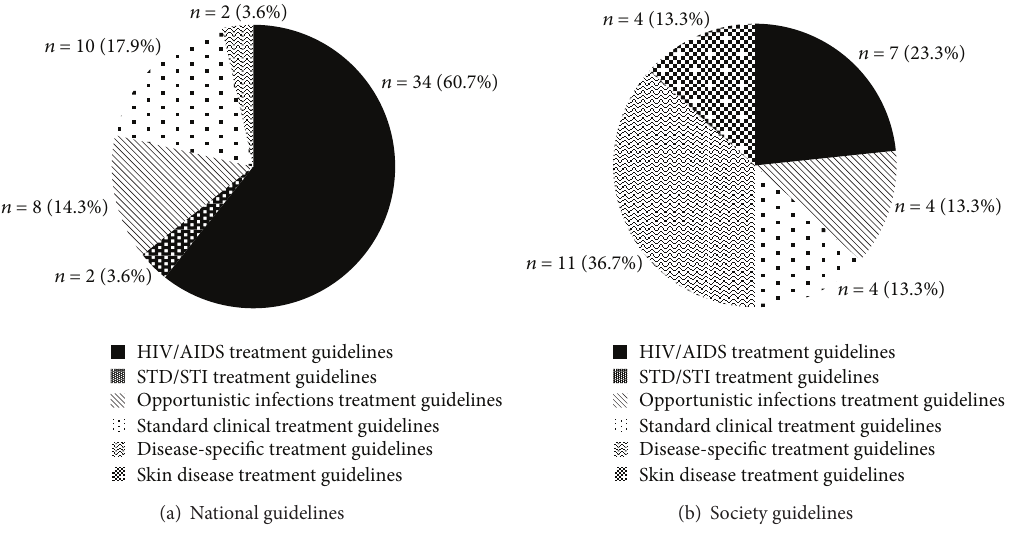
Figure 2: Categories of source documents where treatment of HIV-related skin conditions was mentioned.